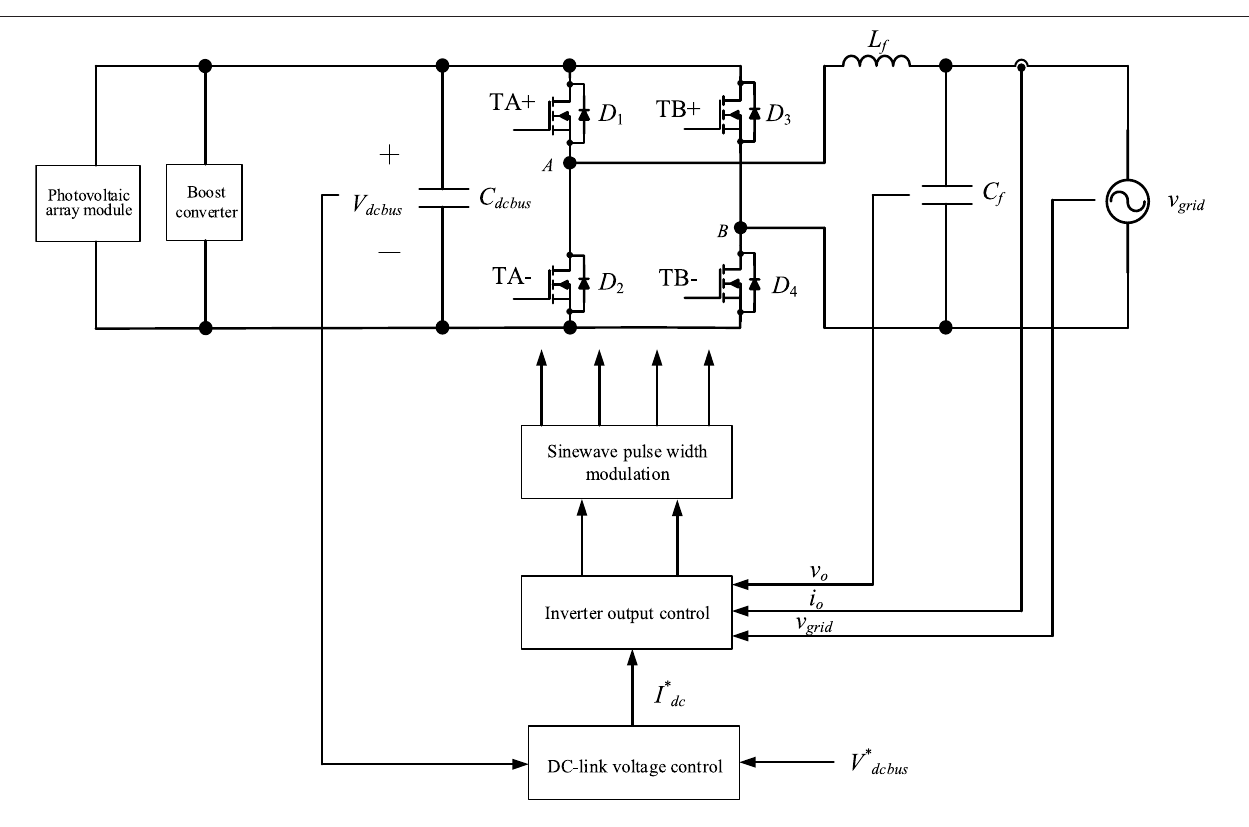
FIGURE 3 | Circuit architecture of a single-phase photovoltaic full-bridge inverter.